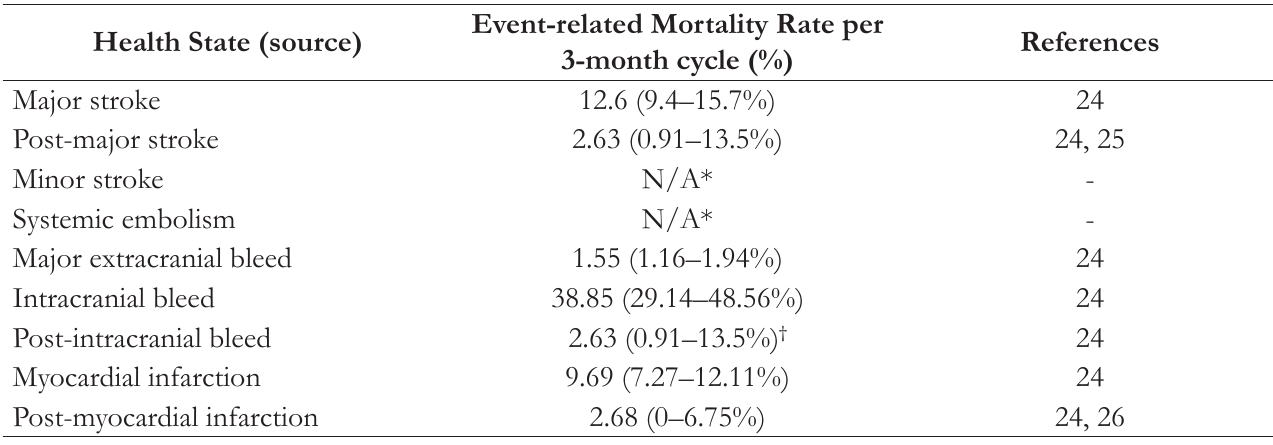
Table 2. Mortality Rates (95 %